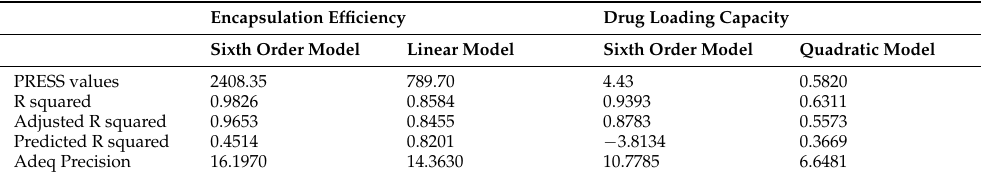
Table 10. Statistical parameters of polynomial models fitted to encapsulation efficiency and drug loading capacity of blend